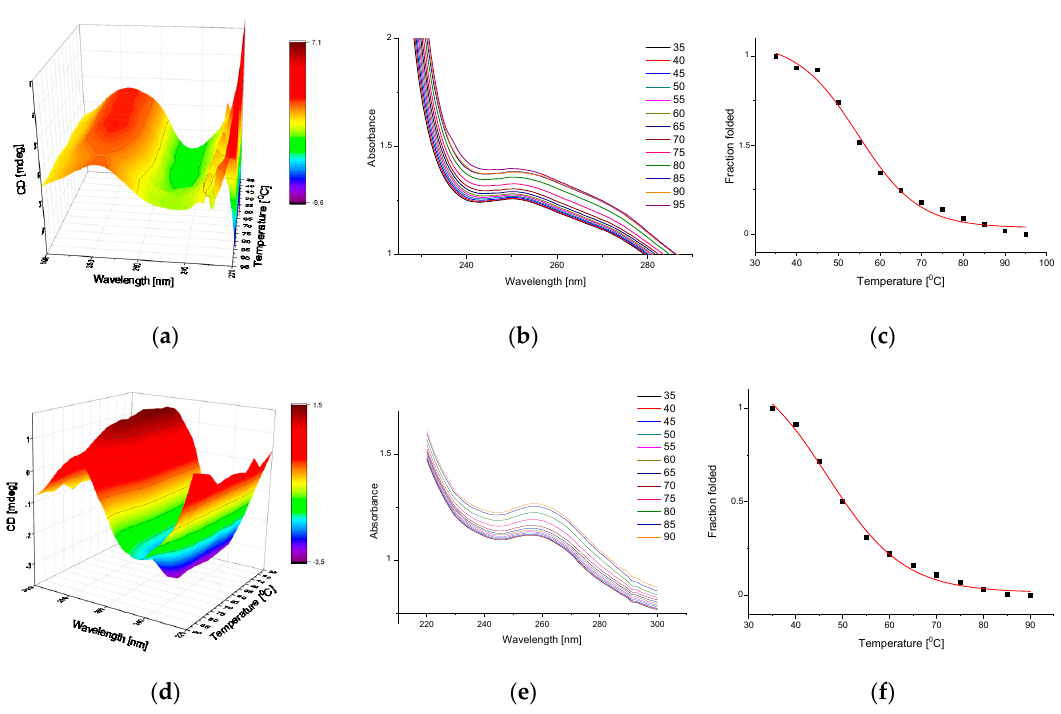
Figure 11. Three-dimensional CD melting of CT-DNA (100 µM) in Tris-HCl/NaCl at pH 7.2 with complexes 2 ( a–c ) and 3 ( d– f ), 2D absorbance spectra at 256 nm and calculated fraction folded as a function of temperature.